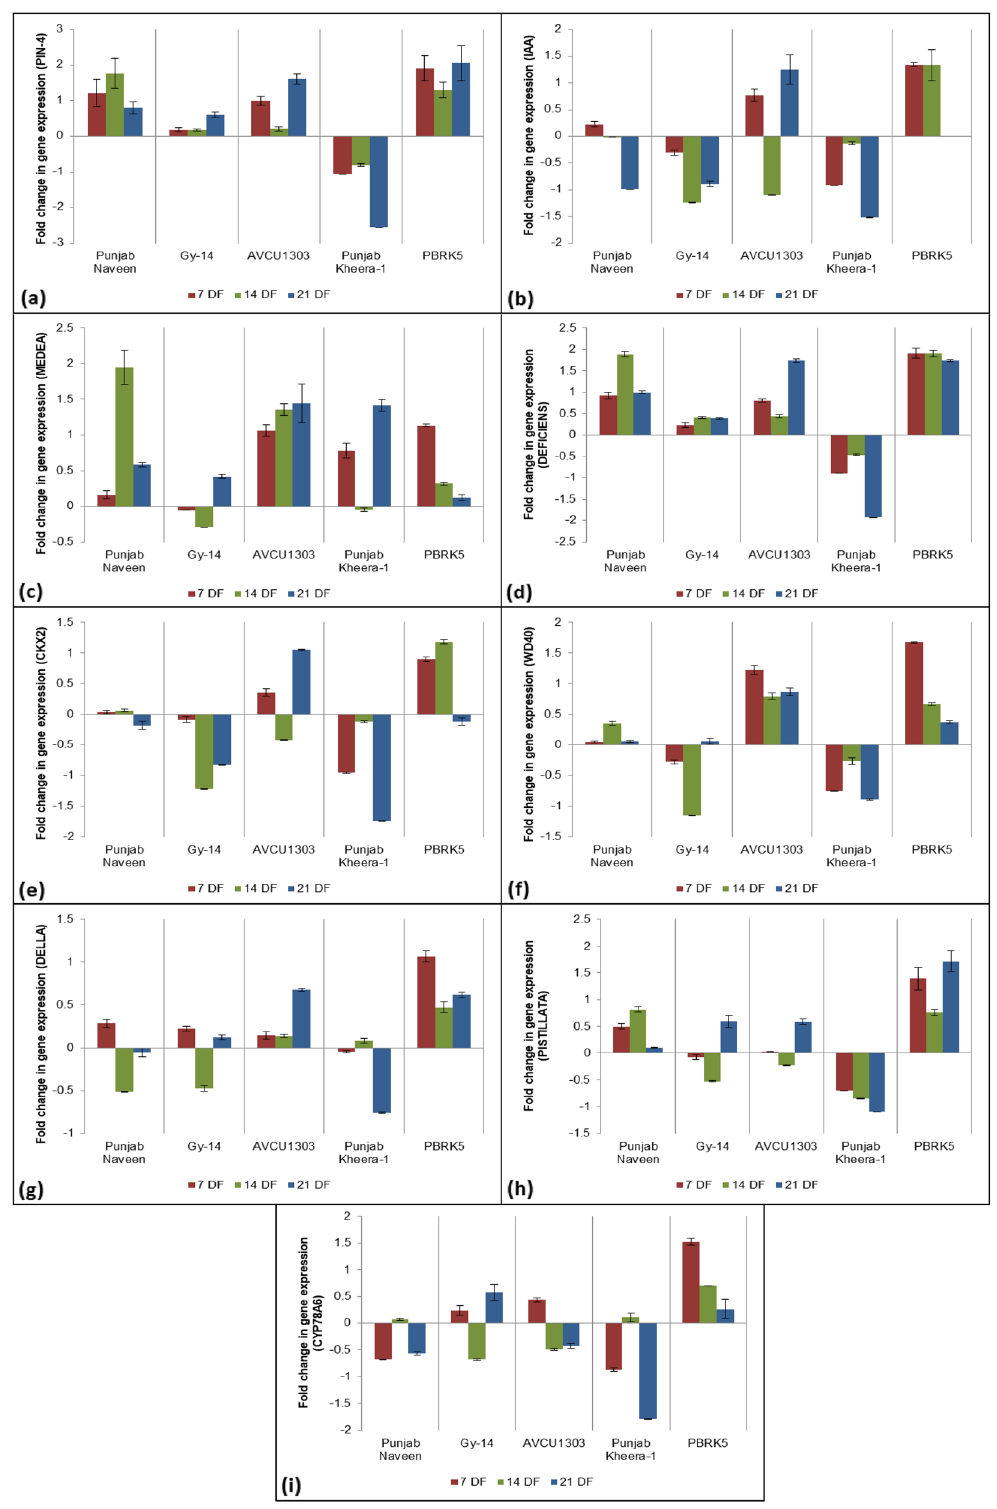
Figure 10. Fold changes in gene expression level of different parthenocarpy related genes at different days after flowering in cucumber ( a ) CsPIN-4 ( b ) CsIAA ( c ) CsMEDEA ( d ) CsDEFICIENS ( e ) CsCKX2 ( f ) CsWD40 ( g ) CsDELLA ( h ) CsPISTILLATA ( i ) CsCYP78A6